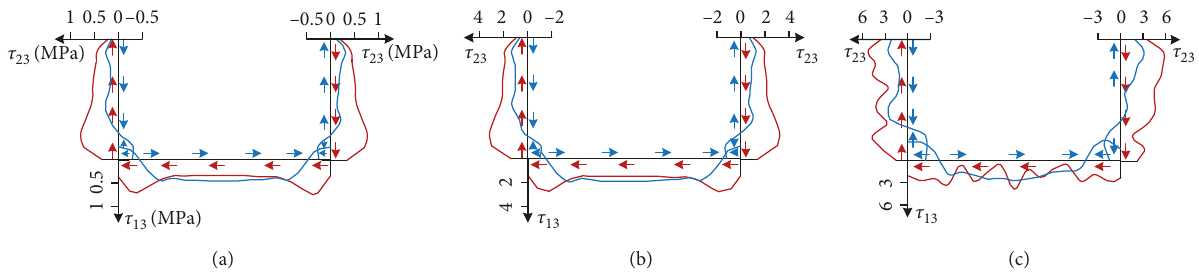
Figure 21: Shear stress distributions around quarter section at different loading levels of (a) 10% ultimate torque, (b) 30% ultimate torque, and (c) 80% ultimate